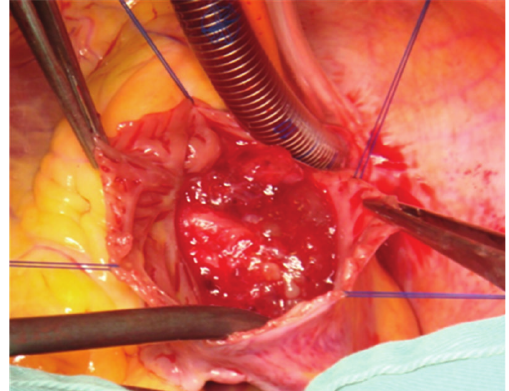
Figure 2: Opening the right atrium with myxoma attached to the interatrial septum (picture is taken from the head end of the patient).